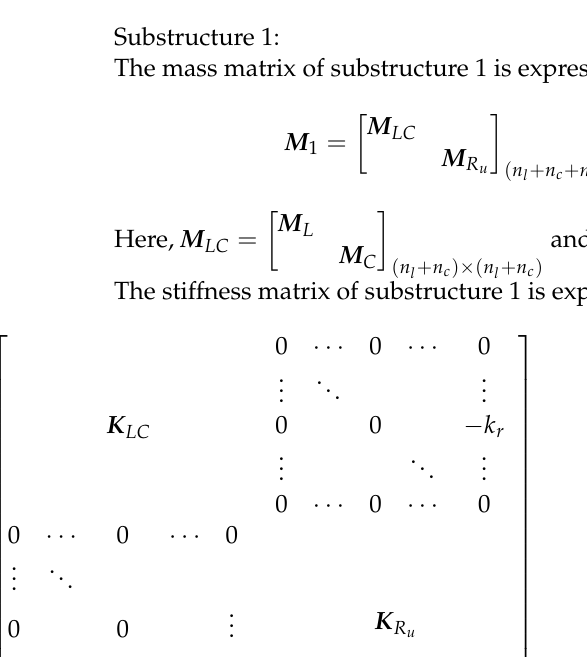
Figure 4. The allocation of the substructure.